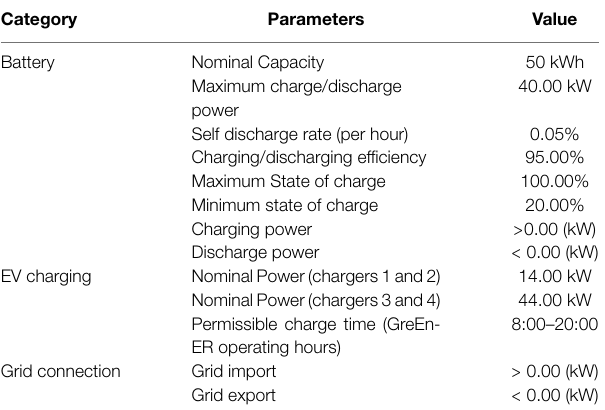
TABLE 4 | Summary of technical parameters used in MILP optimization.